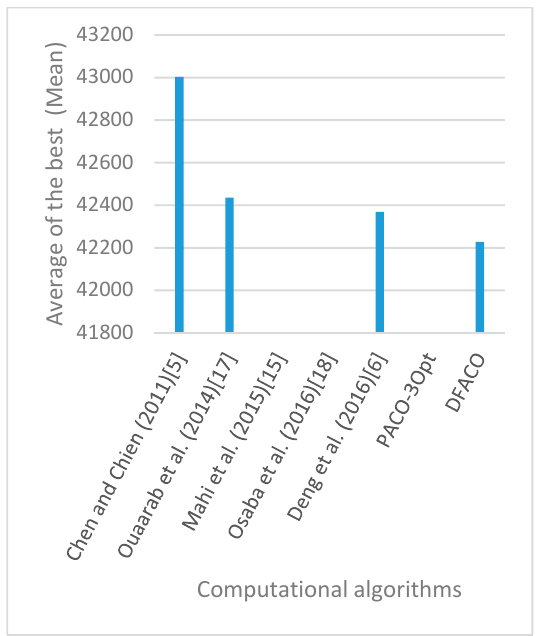
Figure 17. Average of best solutions obtained for instance lin318 by all algorithms.